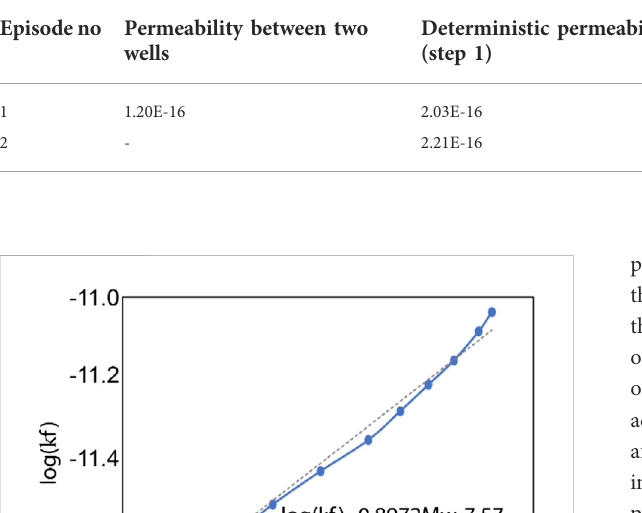
TABLE 2 Cross validation of permeability by different